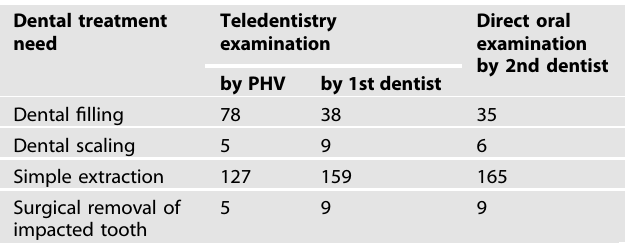
Fig. 3 Intraoral photograph taken by intraoral camera. The photographs indicated a treatment need for dental fi lling (a1 – a2), simple extraction (b1 – b2), dental scaling (c1 – c2), and surgical removal of impacted tooth (d1 – d2), presented alongside the corresponding ICDAS table and the recommended dental treatment need. RCT, root canal treatment. Table 2. The number of teeth that need different dental treatments determined by teledentistry and oral examinations ( N =